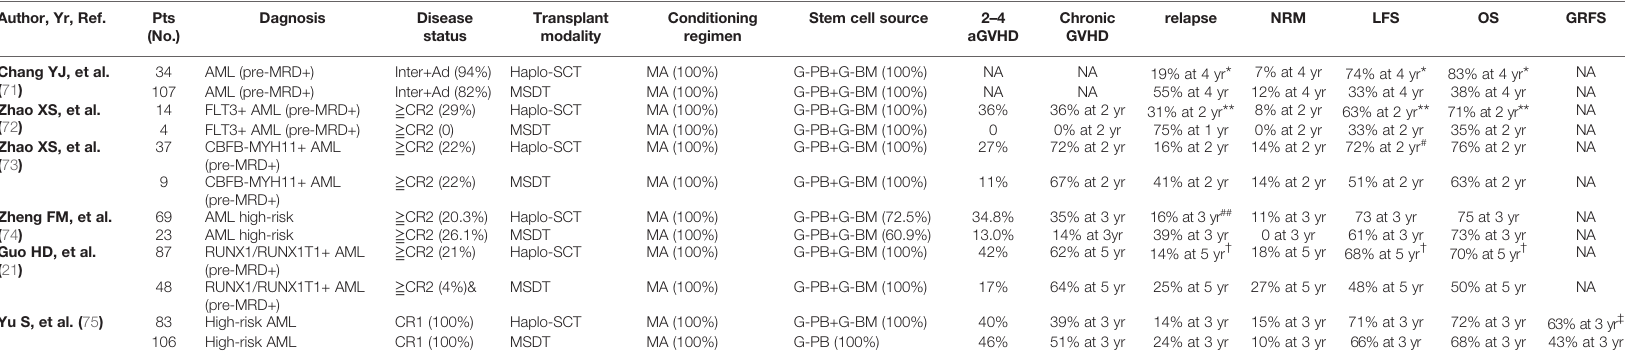
MSDT,humanleukocyteantigen-matchedsiblingdonortransplantation;haplo-SCT,haploidenticalstemcelltransplantation;Yr,year;Ref.,reference;No.,number;aGVHD,acutegraft-versus-hostdisease;NRM,nonrelapsemortality;LFS,leukemia-freesurvival; OS,overallsurvival;GRFS, GVHDandrelapse-freesurvival;pre-MRD,pretransplantationminimalresidualdisease;Ad,advanceddisease;MA,myeloablative;G-PB,granulocytecolony-stimulatingfactor(G-CSF)-mobilizedperipheralbloodharvests;G-BM,G- CSF simulated bone marrow harvests; NA, not available. *P<0.01 for relapse, LFS and OS compared between haplo-SCT and MSDT. **P<0.05 for relapse, LFS and OS compared between haplo-SCT and MSDT. # P<0.05 for LFS compared between haplo-SCT and MSDT. ## P=0.027 for relapse compared between haplo-SCT and MSDT. † P<0.05 for relapse, LFS and OS compared between haplo-SCT and MSDT. ‡ P=0.035 for GRFS compared between haplo-SCT and